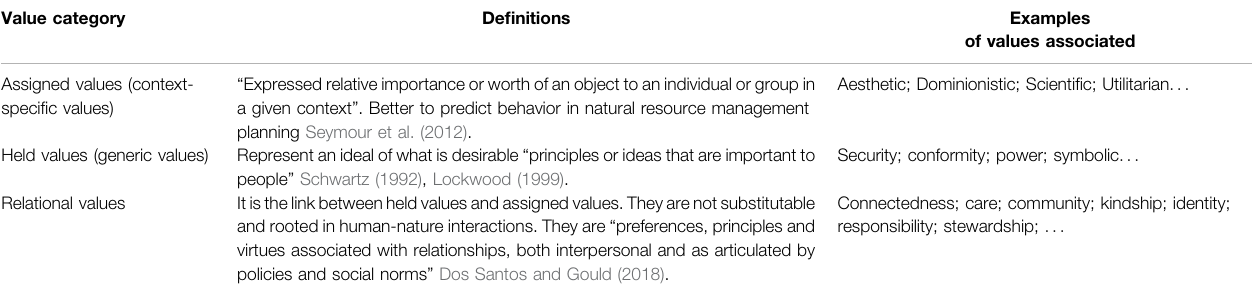
of values associated